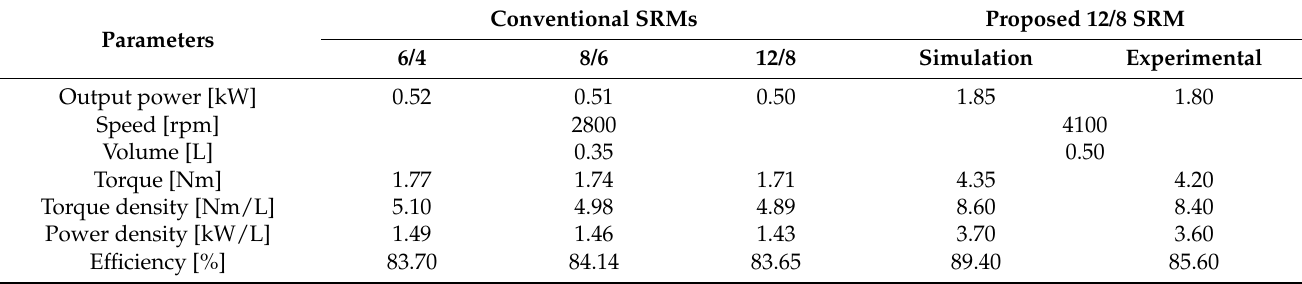
Table 5. Performance comparison of conventional and proposed